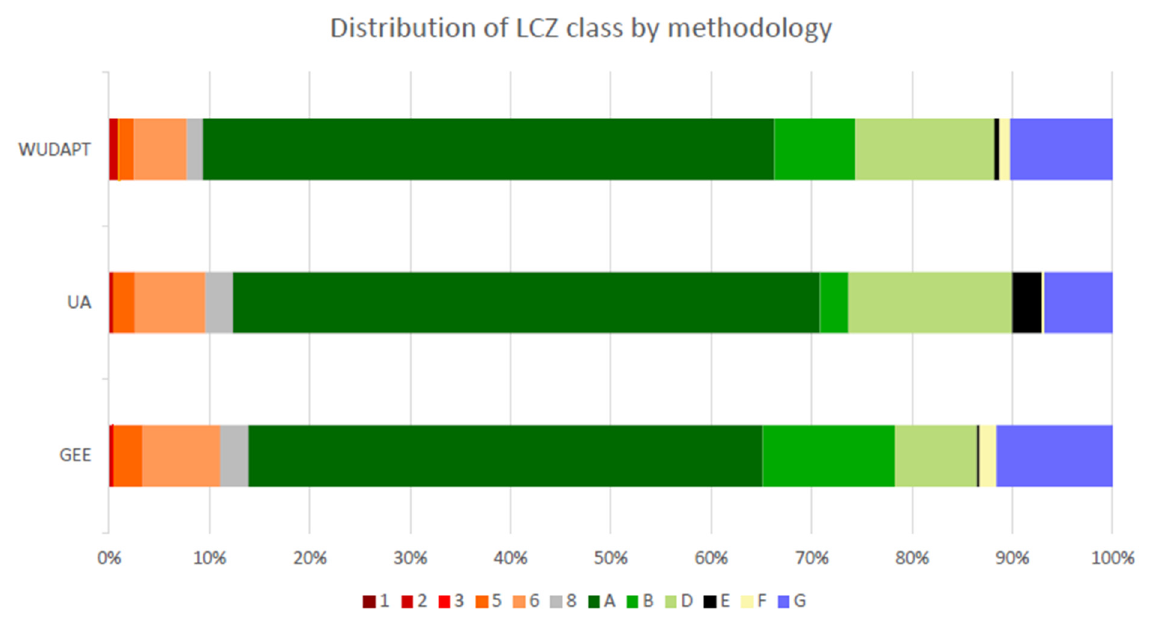
Figure 13. Distribution of LCZ by methodology, % with LCZ types as the color legend.